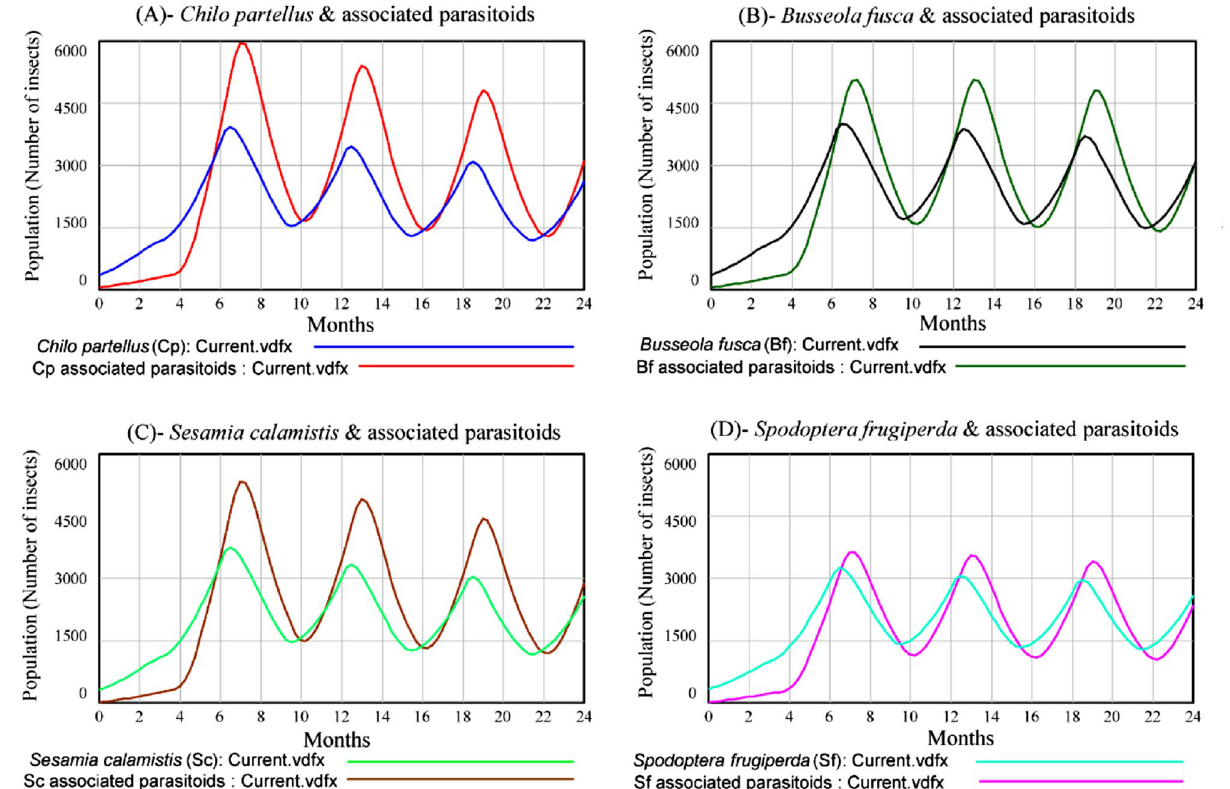
Figure 1. Populations of Chilo partellus ( A ), Busseola fusca ( B ), Sesamia calamistis ( C ) and Spodoptera frugiperda ( D ) as a single pest species with their respective associated parasitoids in the representing 81.18% and 18.82%, respectively of the total pest populations in the system. The population of B. fusca was largely outcompeted by C. partellus after 6 months and its population was drastically reduced in a two species system as compared to when it was the sole species in the system. In the system of either B. fusca and S. calamistis (Fig. 2B) or C. partellus and S. frugiperda (Fig. 2C), bilateral competitive interactions were strong, leading to the decline of both the species populations but without dominance. Although bilateral competitive interactions were revealed in other two multi- pest species systems, C. partellus was most prevalent to S. calamis- tis (Fig. 2D) representing 66.08% and 33.92%, respectively and S. frugiperda was most prevalent to B. fusca (Fig. 2E) and S. calamistis (Fig. 2F) after 6 months and represented 60.53% and 39.47%, respectively of the total pest populations in the system. In addition, the model showed that the populations of each pest species in two pest species systems (Fig. 2A–F) declined as compared to those in sole pest species systems (Fig. 1A–D). How- ever, the average total pest populations (population size of each pest) in sole-pest species systems represented only 85.36% of total average pest populations in two-pest species systems (population size of any given combina- tion of two pest species). In each combination, the associated parasitoid populations proportionally varied with their respective host population fluctuation as parasitoid population tracked the peaks of the pest population. Three and four pest species and associated parasitoids and the resource (maize plants). In three species systems after 6 months, C. partellus and S. frugiperda co-exist representing 45.45% and 40.42% of the total pest populations in the system but competitively dominated B. fusca population that represented only 14.13% (Fig. 3A). However, in C. partellus + S. calamistis + S. frugiperda three species system, S. calamistis became dominant over S. frugiperda (Fig. 3B). They represented 44.80%, 31.43% and 23.77% , respectively of the total pest populations in the system. The system of the three stemborer species (Fig. 3C) showed the dominance of C. partellus (47.93%) followed by S. calamistis (31.70%) and B. fusca (20.37%), respectively. Spodoptera frugiperda was the dominant species followed by B. fusca and S. calamistis in three pest species system (Fig. 3D). In each system, the parasitoid population fluctuation evolved according to its host population fluctuation. Furthermore, the model showed that the population of each pest species in three pest species systems (Fig. 3A–D) declined as compared to those in two pest species systems (Fig. 2A–F). However, the average total pest populations in two-pest species systems represented only 70.07% of total average pest populations in three-pest species systems. In four pest species system, C. partellus was the dominant species (48.79%), followed by S. calamistis (28.34%), S. frugiperda (14.85%) and B. fusca (8.02%), respectively (Fig. 3E), with the same trend of their associated para- sitoids (Fig. 3F). Comparing four pest species system populations to those in three pest species systems, the population of each pest species declined except that of C. partellus . The total average pest populations in three- pest species systems represented only 89.88% of those in four pest species system.